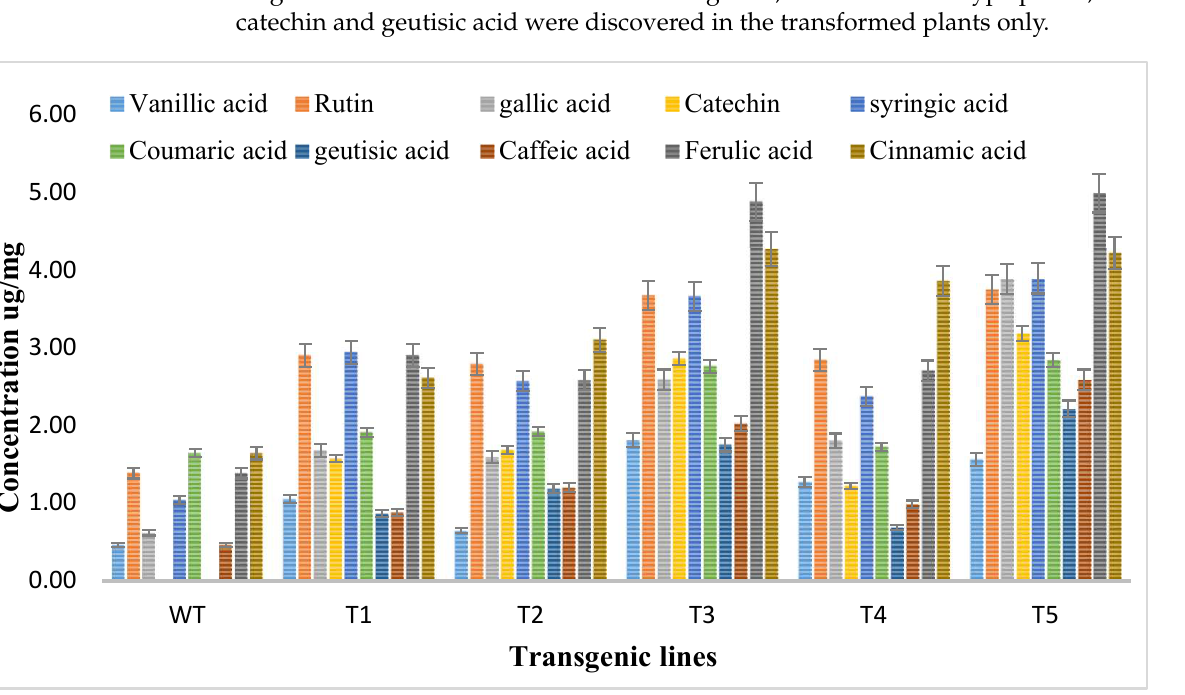
Figure 5. Quantitative analysis of flavonoids by HPLC in A. carvifolia rol A transgenic lines and wild type plants. Table 2. Two-way ANOVA for HPLC analysis